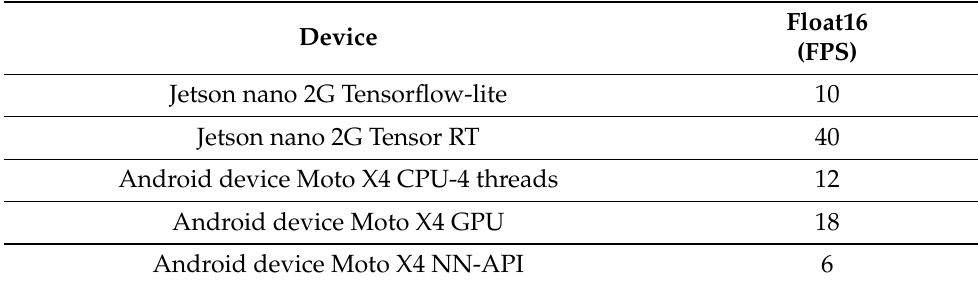
Table 8. Frames per second in embedded devices.